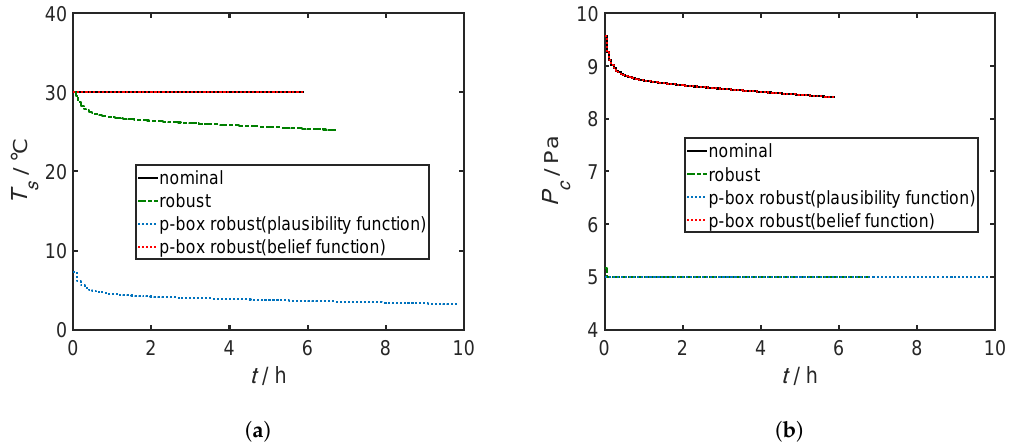
Figure 4. Designed profiles for the shelf temperature T s ( a ) and the chamber pressure P c ( b ) of the nominal, robust, p-box (plausibility function) robust, and p-box (belief function) robust